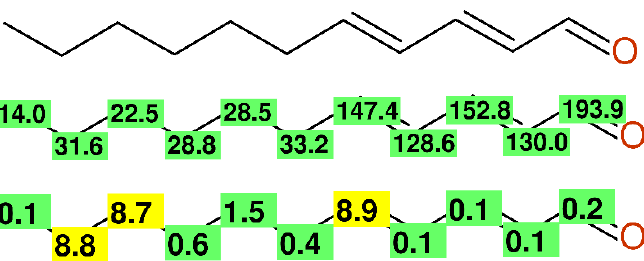
Figure 8. Misassigned alkyl-chain of compound 11 from [51]. Experimental chemical shift values ( middle ) and differences between experimental and predicted chemical shift values ( bottom ).